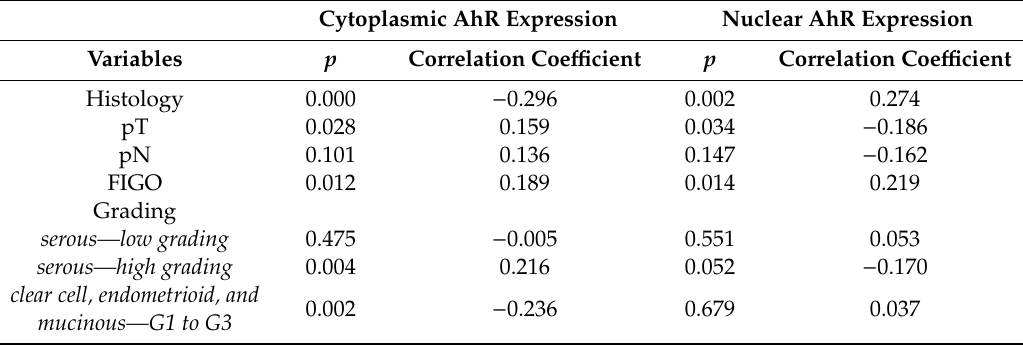
Table 1. Correlations between high cytoplasmic / nuclear AhR expression and clinical